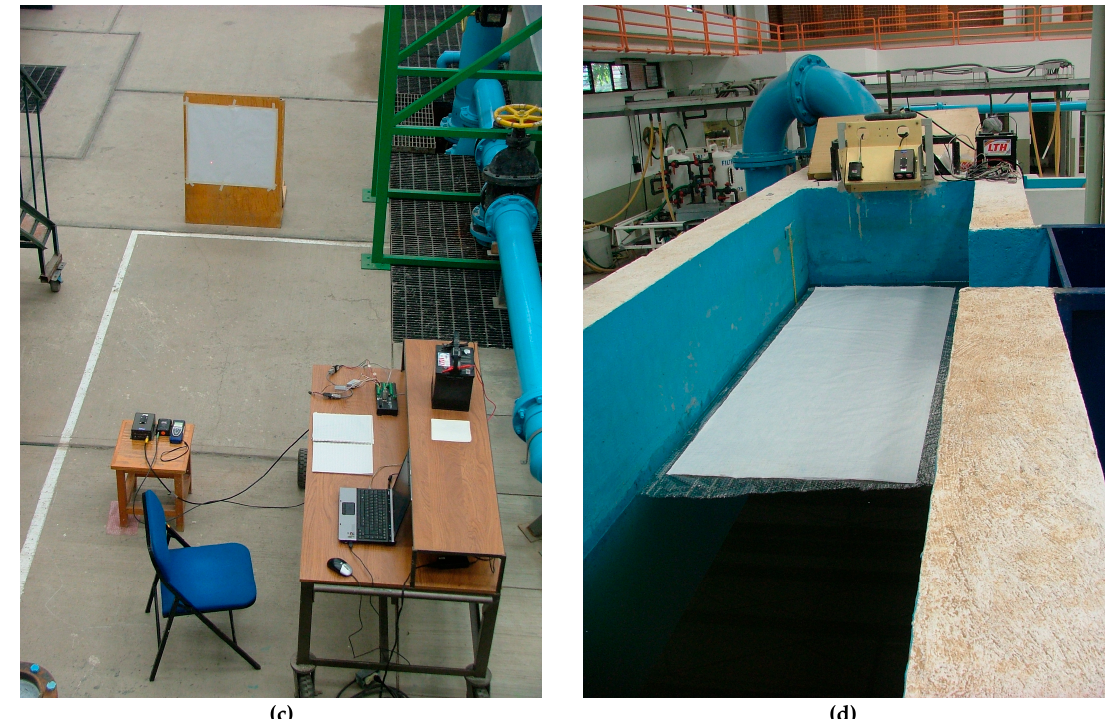
Figure 2. Laboratory testing: ( a ) three simple Lidar instruments: a “Disto A6” handheld laser rangefinder (left), the “TruSense S200” Lidar described in this study (center) and an “ULS” Lidar discarded after preliminary tests (right); ( b ) inclinable support used to adjust the Lidar incidence angle (with an “MTi” inclinometer at the center); ( c ) checking the ability of Lidar to measure the distance to a diffuse surface (white paper sheet); ( d ) water tank filled with turbid water and with a thin diffuse layer temporarily placed at the surface.